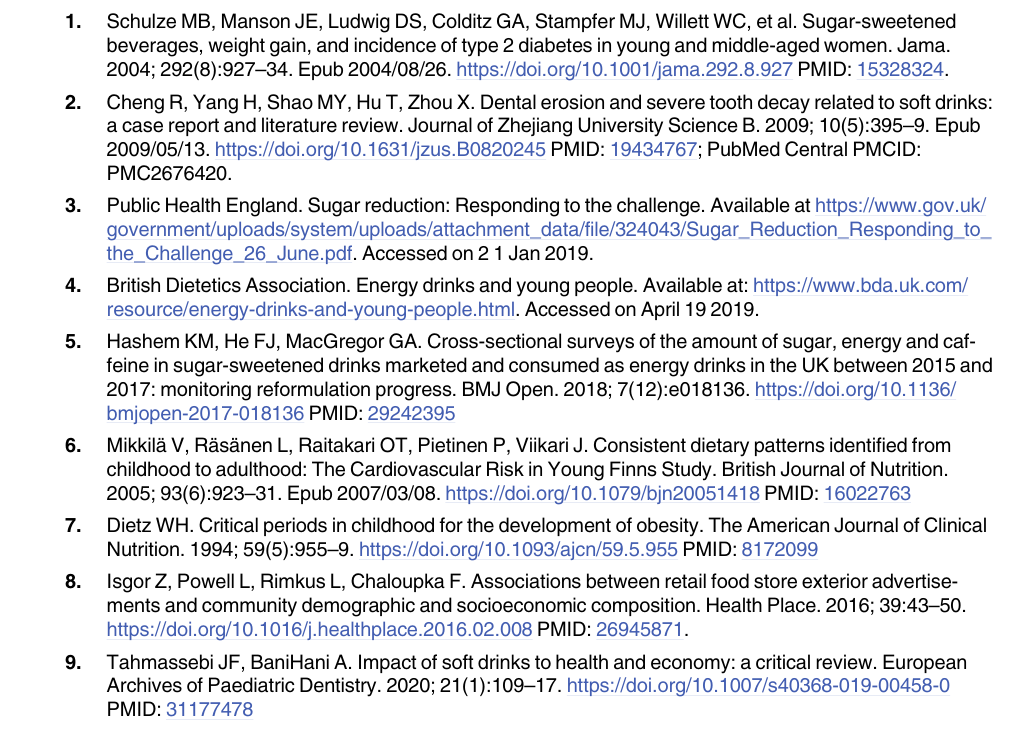
S2 Fig. Weekly SSB time trends according to socioeconomic grouping.